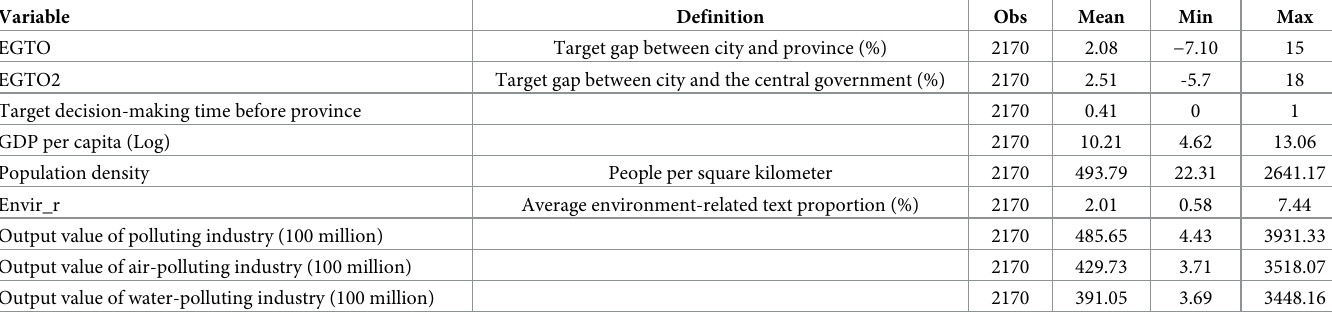
Table 1. Definition and summary statistics for the main variables used in our analysis.